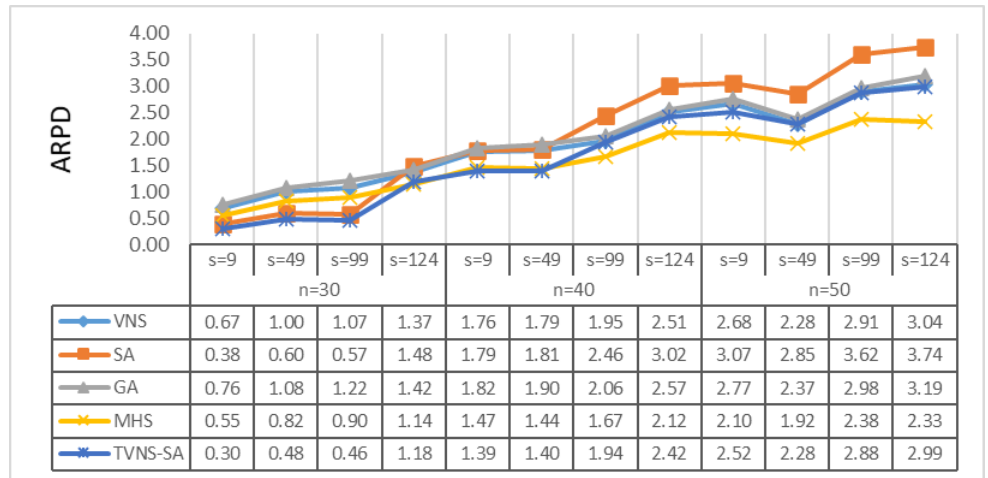
Figure 9. Computational results with a different range of setup times.